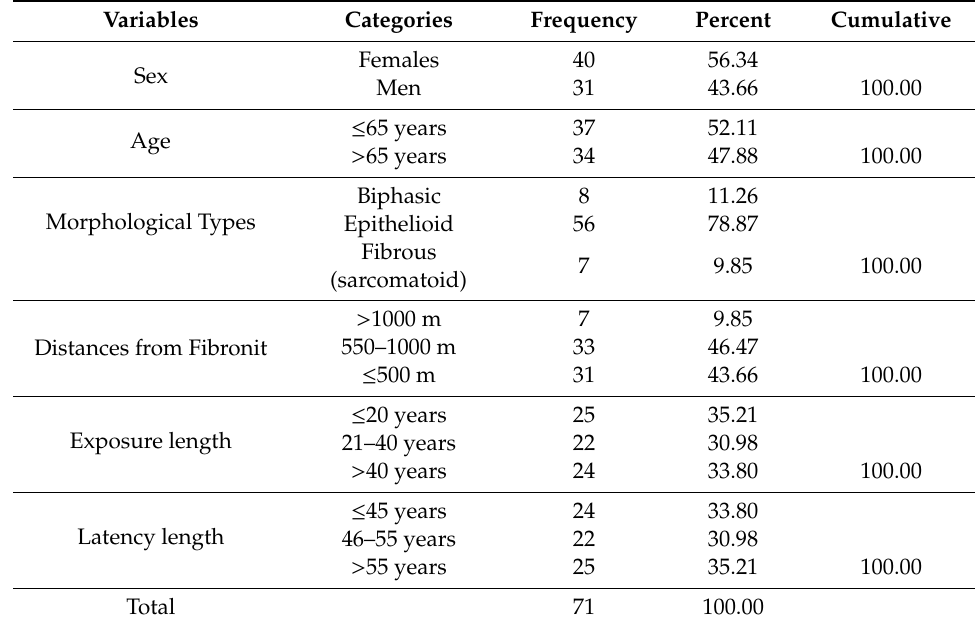
Table 1. Main characteristics of the mesothelioma cohort.